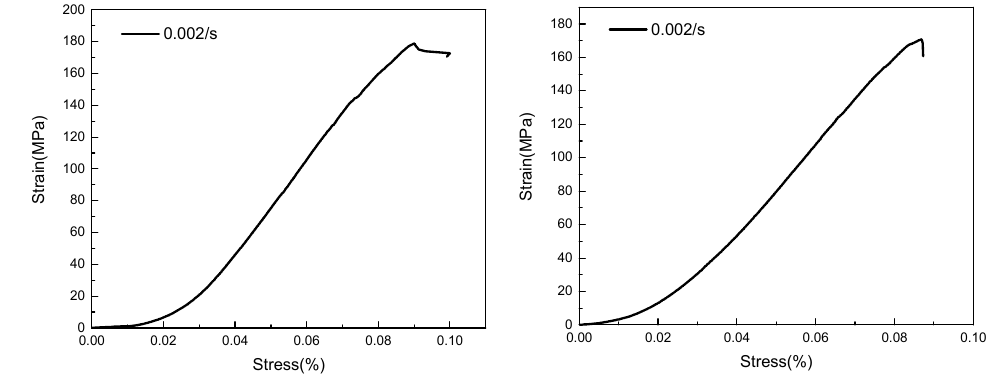
Figure 11. Stress-strain curves of two materials under high-speed impact. ( a ) Unidirectional prepreg composites. ( b ) Plain weave prepreg composite.